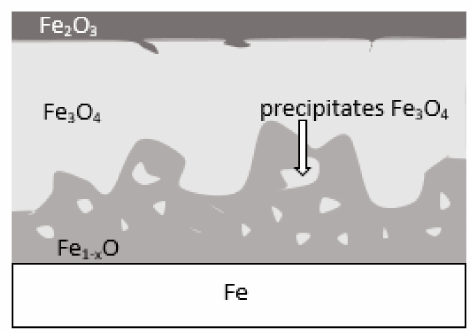
Figure 9. Schematic representation of the iron surface after oxidation in air at high temperature—based on reference